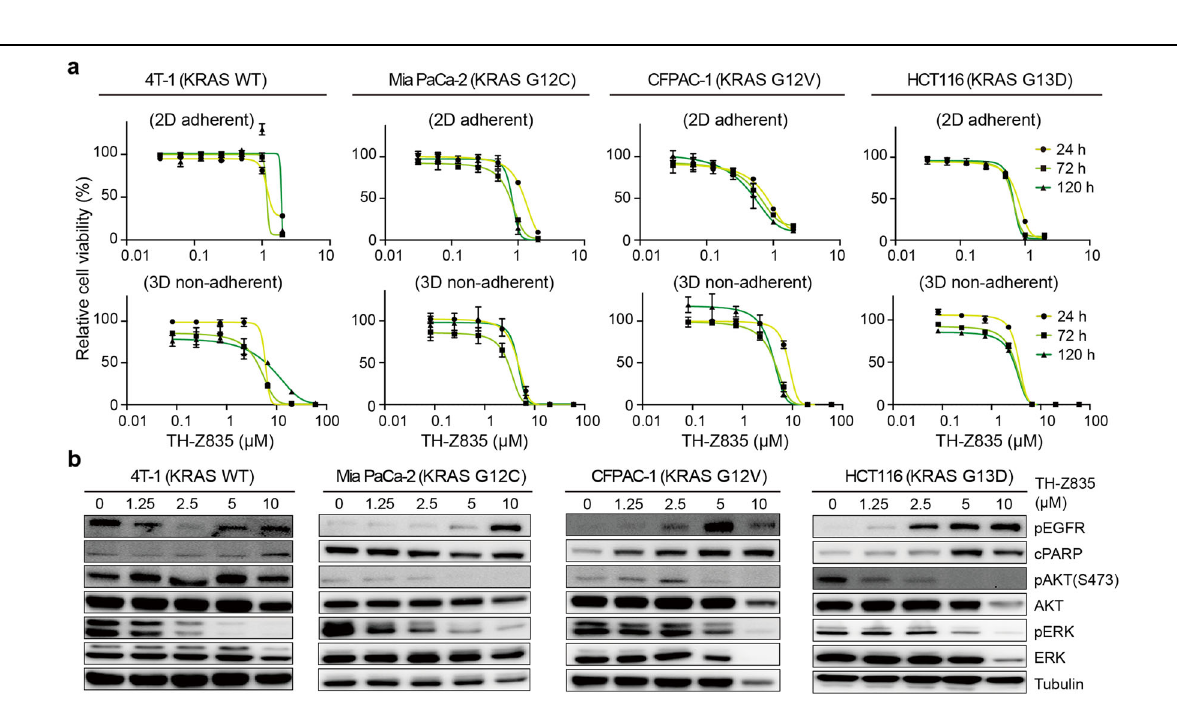
Fig. 6 Anti-proliferative effects and signaling inhibition of TH-Z835 on non-KRAS(G12D) cells. a Cell viability assays of 4T1, MIA PaCa-2, CFPAC- 1, and HCT116 cells with indicated concentration of TH-Z835 for 24 h, 72 h, or 120 h in 2D adherent assays (upper panel) and 3D non-adherent assays plates (lower panel). b Immunoblotting of EGFR, ERK, AKT phosphorylation, and cPARP in 4T1, MIA PaCa-2, CFPAC-1, and HCT116 cells treated with TH-Z835 for 3